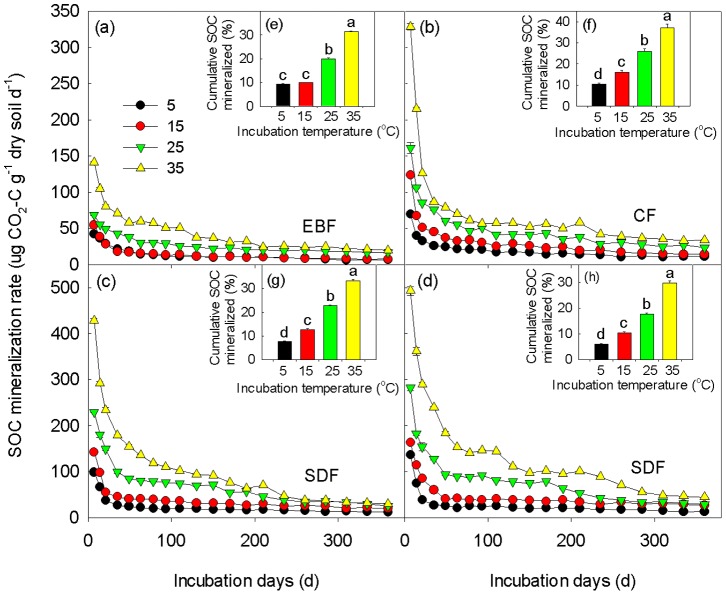
Variation in the rates of SOC mineralization during the whole incubation at different incubation temperatures (5, 15, 25, and 35°C) in EBF (a), CF (b), SDF (c), and AM (d).Inserted panels e for EBF, f for CF, g for SDF, and h for AM show the cumulative percent of SOC mineralized during the whole incubation. Different letters indicate significant differences in the cumulative percent of SOC mineralized among different incubation temperatures at P<0.05. Values are Mean±SE. EBF, evergreen broadleaf forest; CF, coniferous forest; SDF, sub-alpine dwarf forest; AM, alpine meadow.